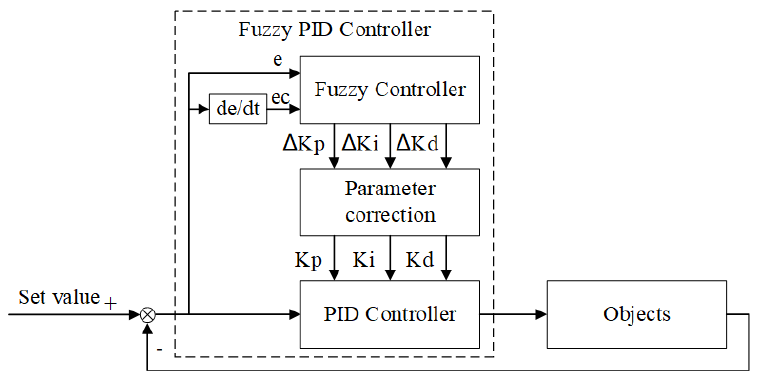
Figure 11. Schematic of the fuzzy PID controller.